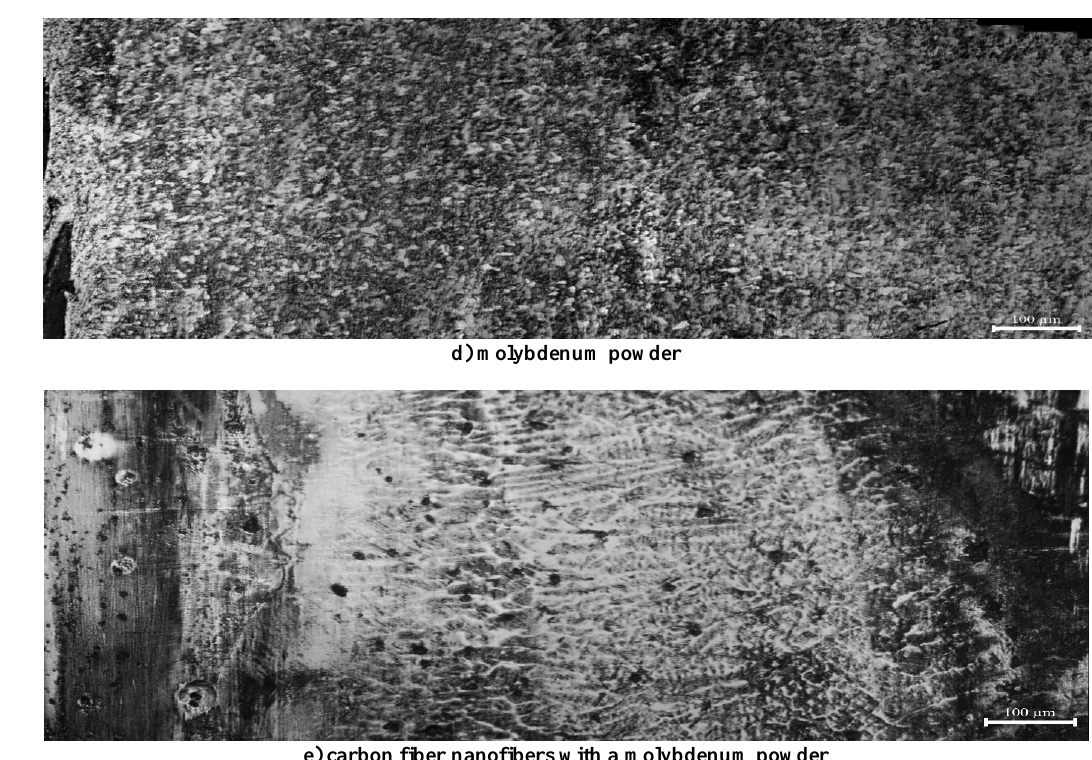
Fig. 3. Panoramic photographs of microstructures of the nucleus of contact melting between Armco iron and common quality carbon steel in the presence of a gasket with doping components (on the left - Armco iron) Study of the nucleus of contact melting between Armco iron and common quality carbon steel in the presence of carbon nanofibers between them (Fig. 3a) showed that a microstructure that corresponds to a high- carbon alloy with a structure of ledeburite was formed. Welding at the same time happened with a lower level of energy attachment, indicating the occurrence of contact melting processes [5,